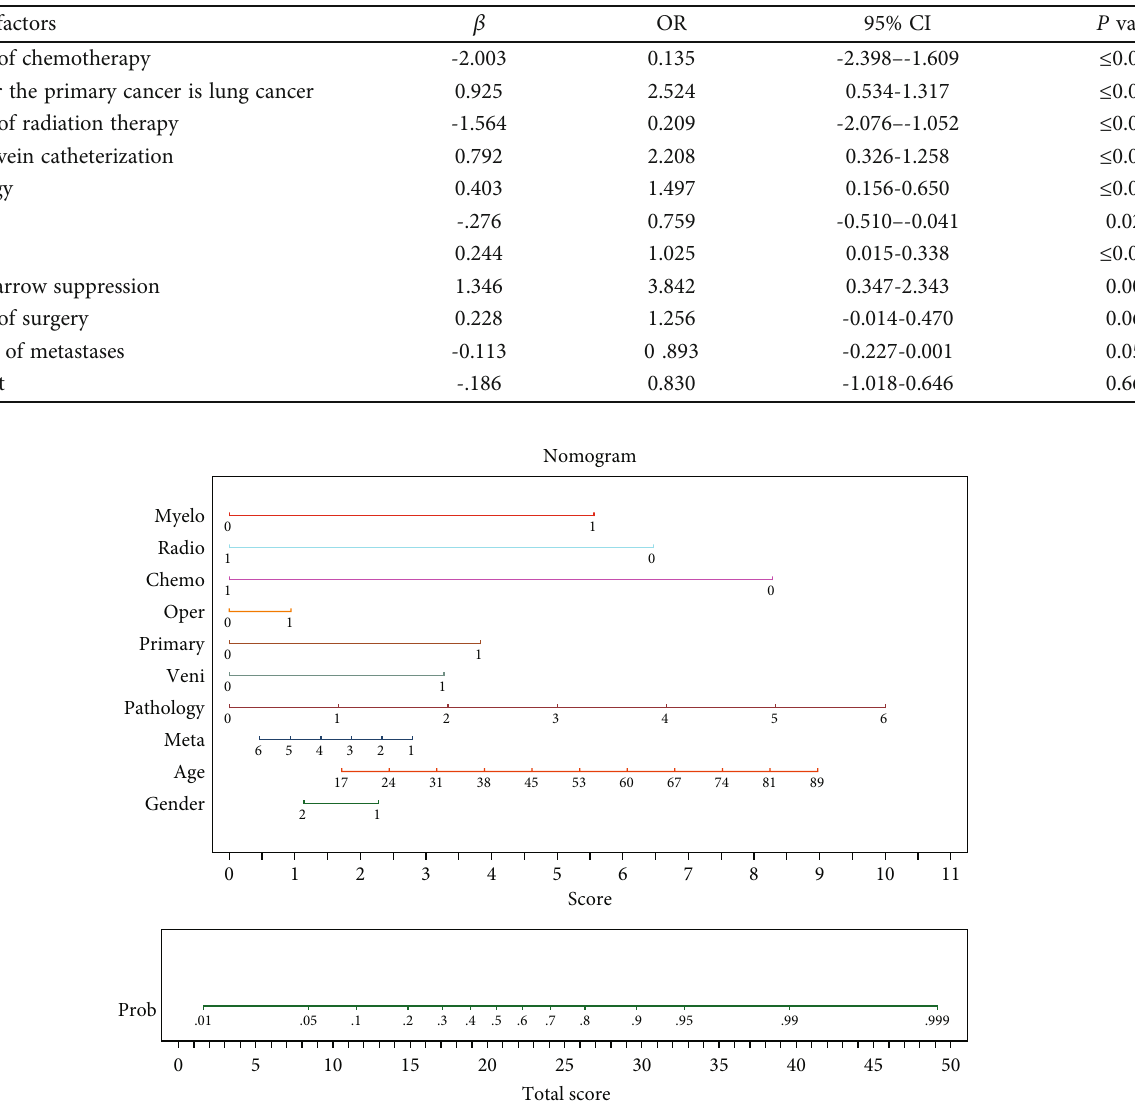
Figure 1: Nomogram to estimate the likelihood of developing lung infections in patients with advanced cancer. Find the predictor points on the uppermost point scale that correspond to each patient variable and total them. The total score projected on the bottom scale indicates the percentage of probabilities of concurrent pulmonary